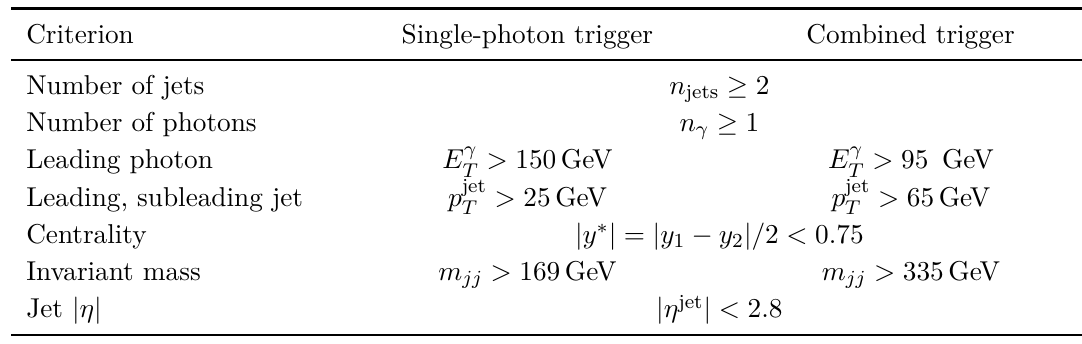
Table 1 . Selection criteria of ref. [62]. Here y 1 and y 2 denote the rapidities of the leading and subleading jet (in p ). See text for the other T